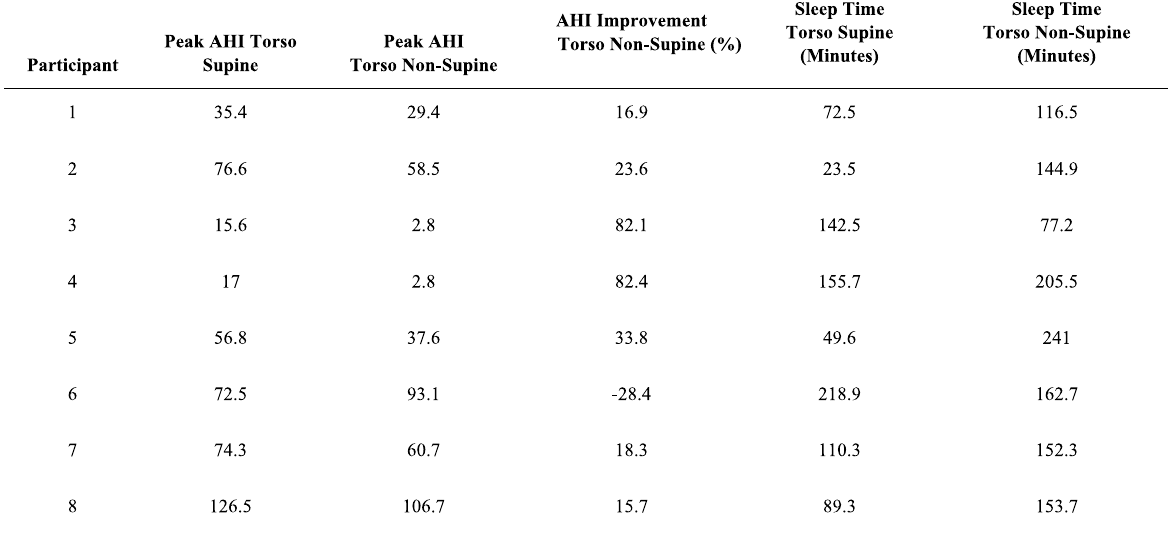
Table 2 Polysomnographic results and peak AHI in the torso supine vs non-supine versus torso